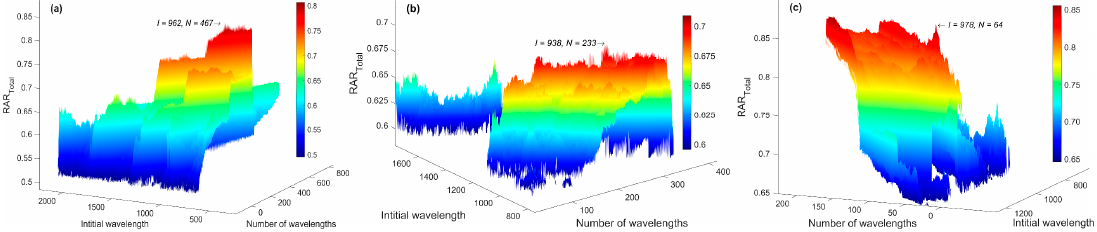
Figure 3. The 3D effect diagrams of the modeling discrimination effect of MW-kNN models of three measurement modals for the initial wavelength ( I ) and the number of wavelengths ( N ): ( a ) 1 mm, ( b ) 4 mm, ( c ) 10 mm.